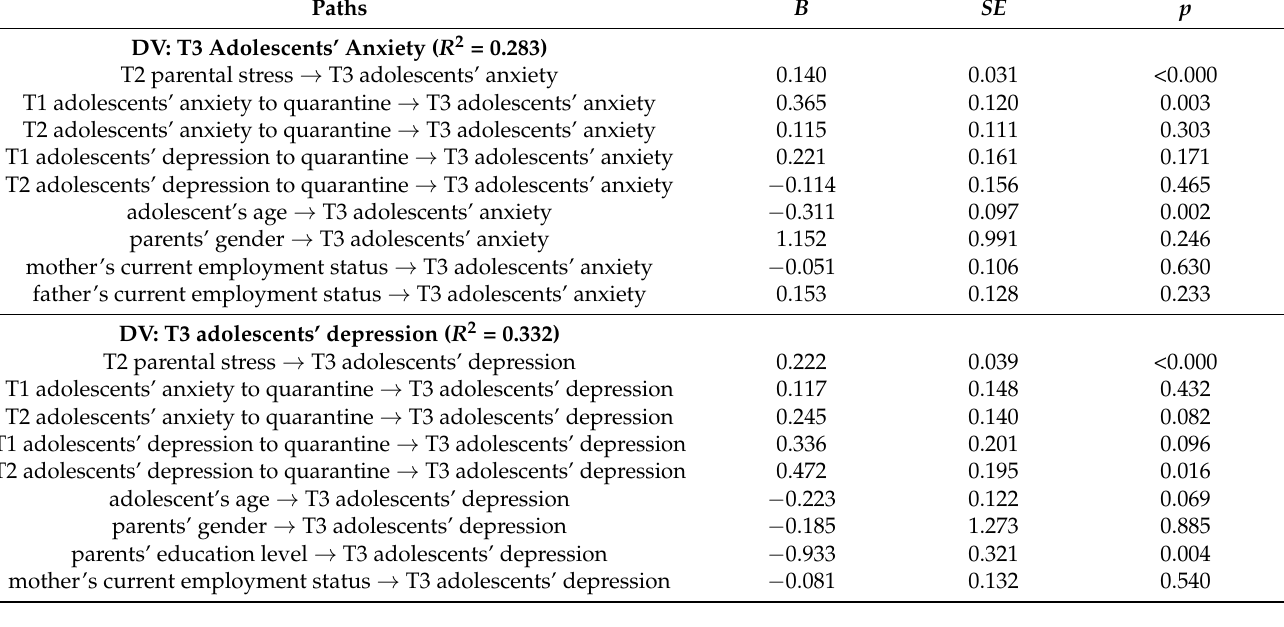
Table 3. The total effect of each pathway in the models ( n = 288). Paths